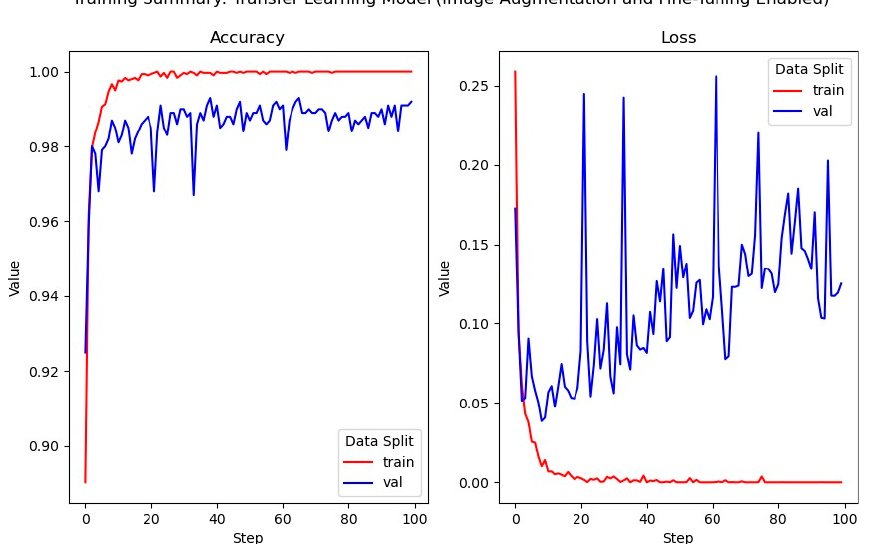
Figure 12. Training summary of the VGG-16 transfer learning model with convolution blocks unfrozen.